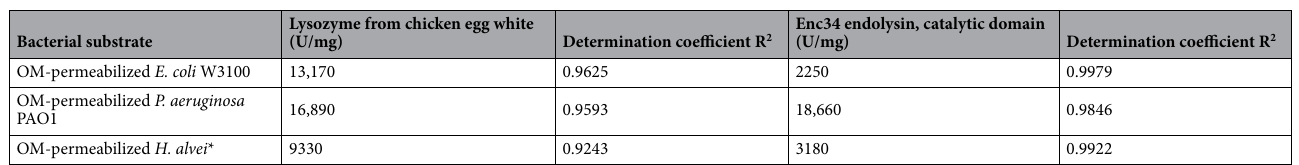
Table 1. Enzymatic activity of the phage Enc34 endolysin and comparison to chicken egg white lysozyme. OM outer membrane. Activity units and determination coefficients for the linear regression analysis are calculated according to 22 . Locally isolated and sequenced bacterial strain is indicated by an asterisk. Raw data can be found in the Supplementary Table